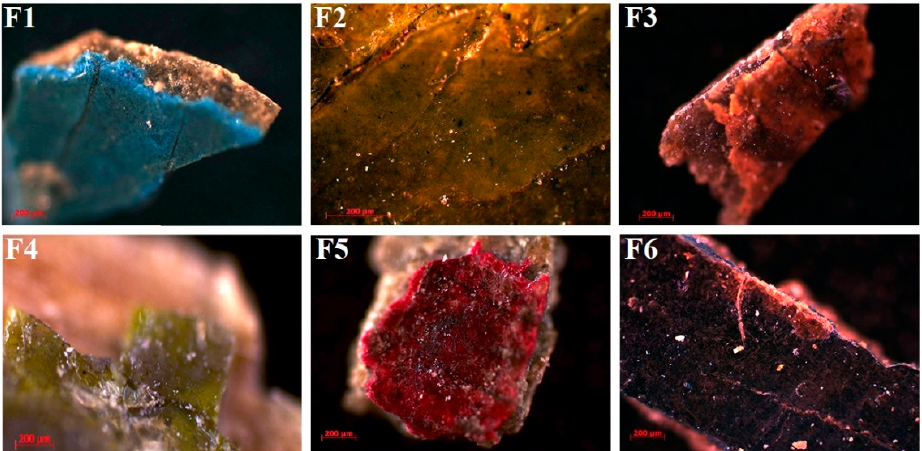
Figure 6. The 6 samples area taken from the pictorial layer of the Saint George icon (×100): F1—blue background; F2—aureole; F3—carnage; F4—green background; F5—red garment; F6—blue garment.